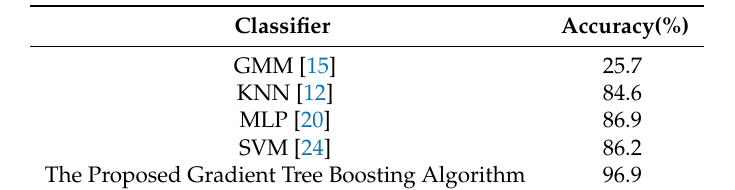
Table 2. Classification Performance of